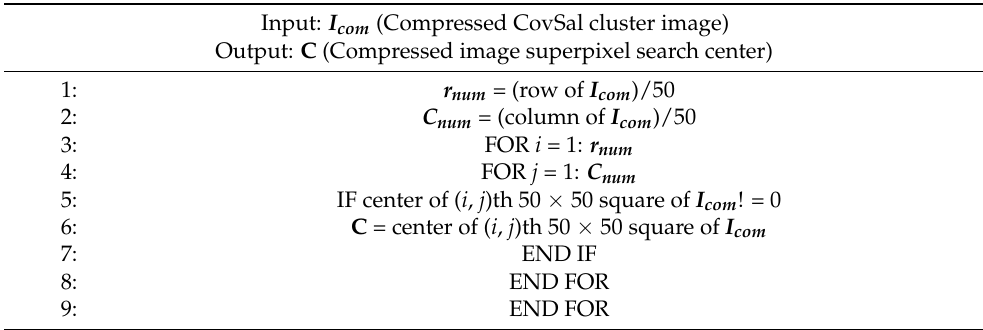
Table 2. Initial position search algorithm for superpixels in a compressed CovSal